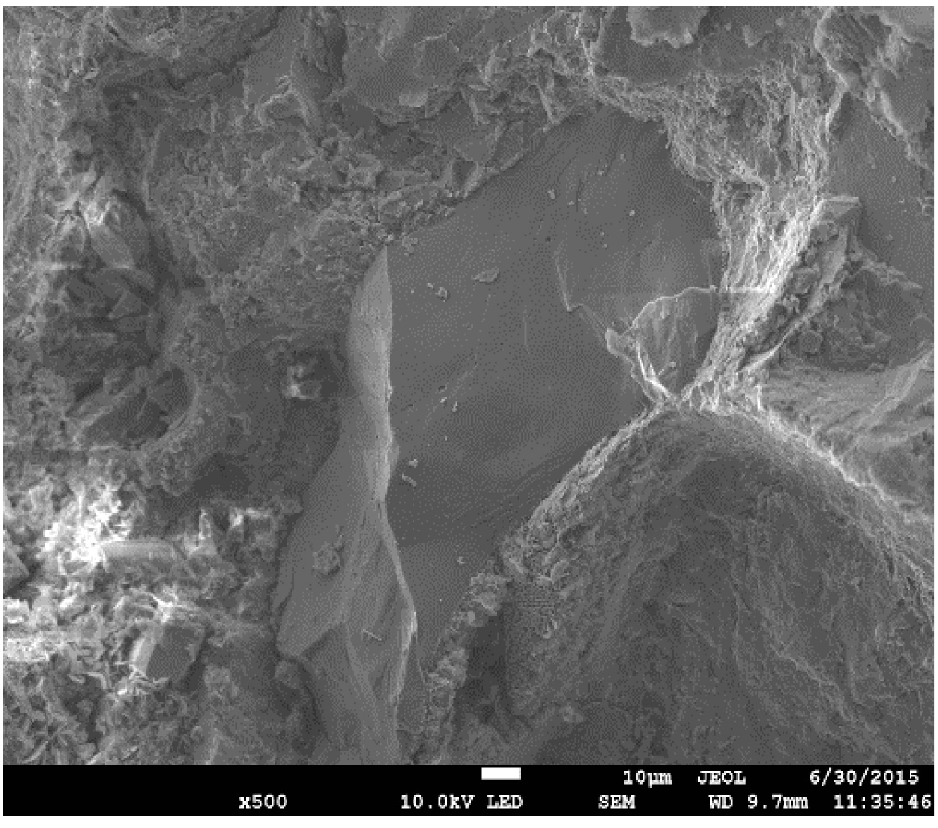
Fig 3. Sandstone internal particle micro-structure scanned by SEM